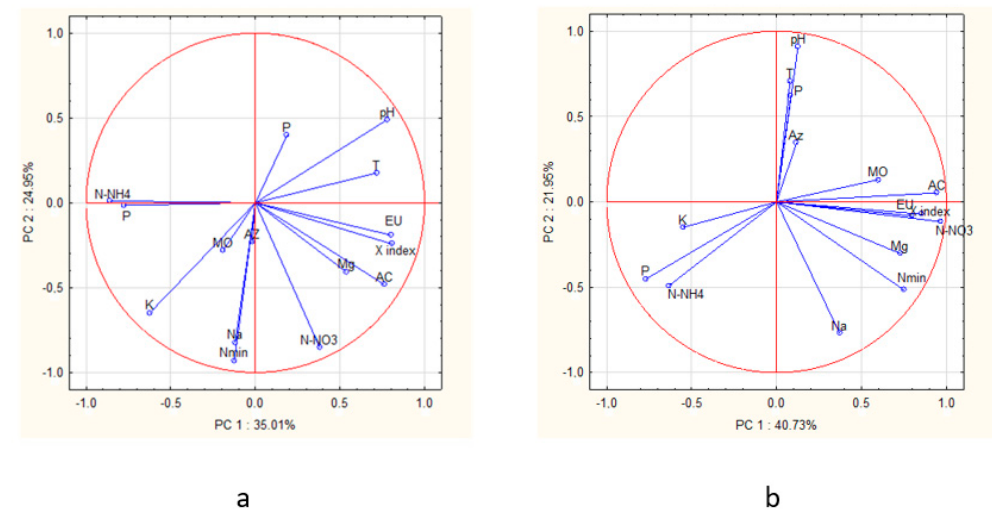
Figure 6. ( a ) Distribution of soil microbiological and chemical properties in the grazed sward and